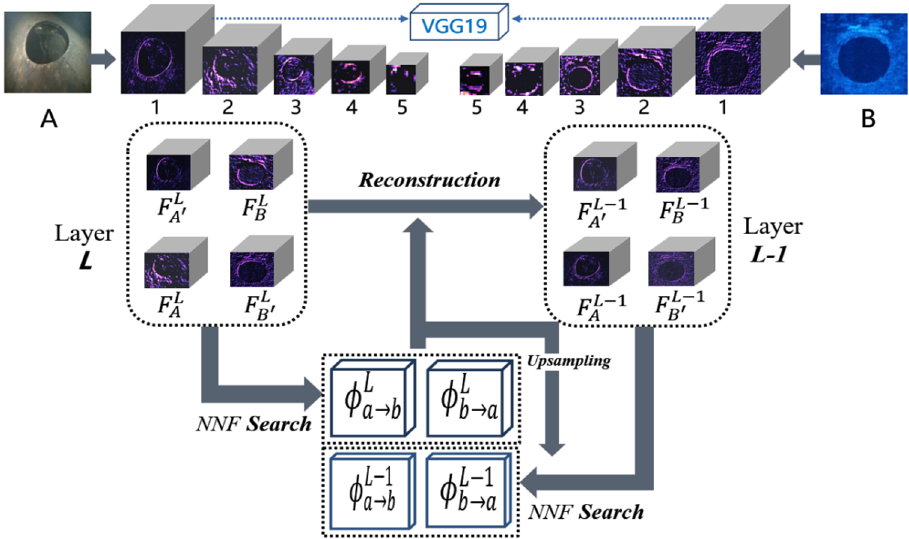
Figure 2. The image attribute transfer process.